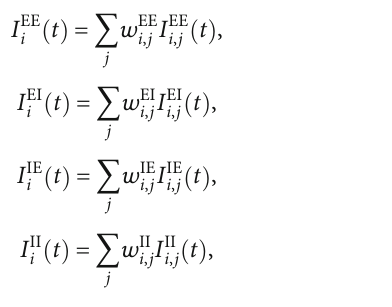
ð t Þ and v I ð t Þ are the membrane potentials for the Here, v E i i excitatory neurons and inhibitory neurons, respectively.